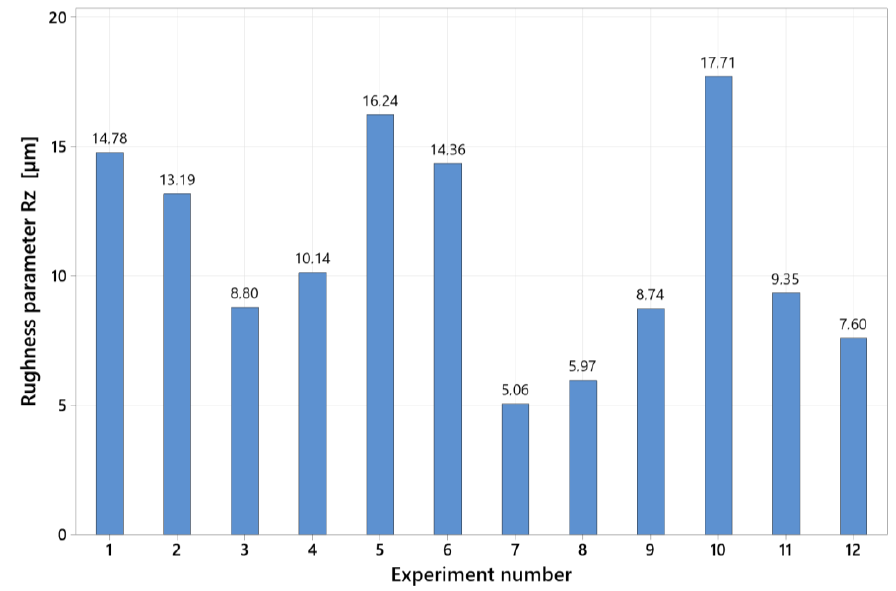
Figure 10. Values of the roughness parameter of the machined surface Rz.